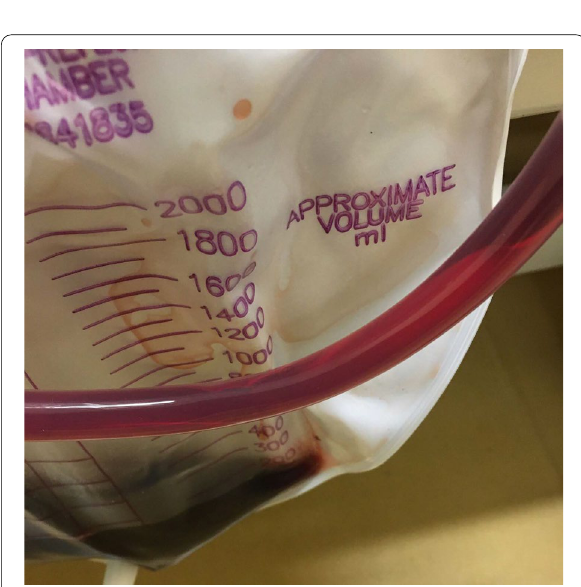
Fig. 2 Hemoglobinuria associated with Clostridium perfringens sepsis-induced